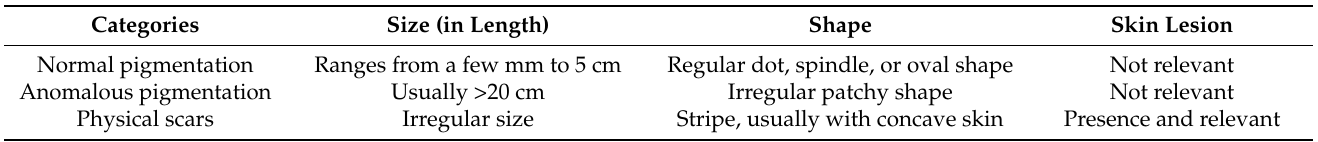
Table 1. Characteristics used to distinguish normal pigmentation, abnormal skin coloration due to physical injuries, and anomalous body color used in this study.